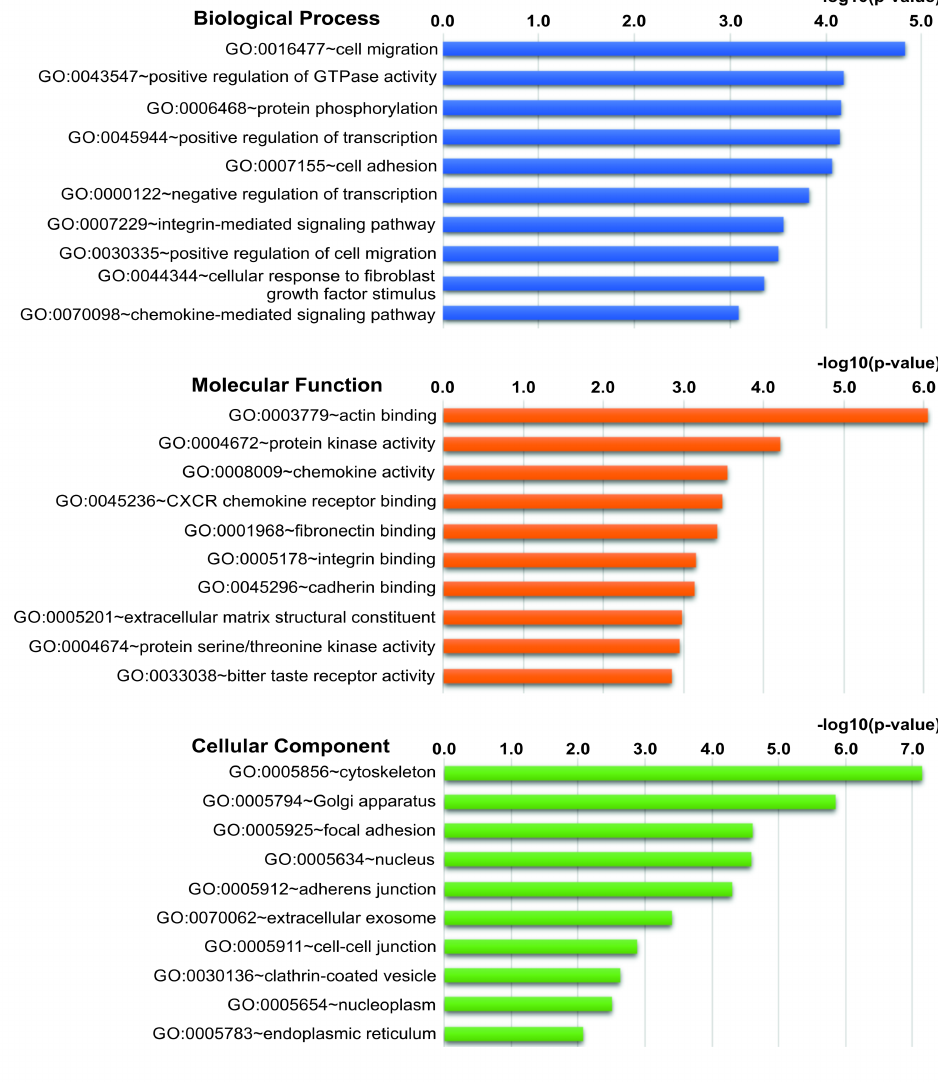
Figure 3. Gene Ontology functional enrichment analyses. Top ten enriched GO terms based on the categories “Biological Process”, “Molecular Function”, and “Cellular Component” by querying the DAVID database with the 952 DEGs identified in hEDS/HSD vs.